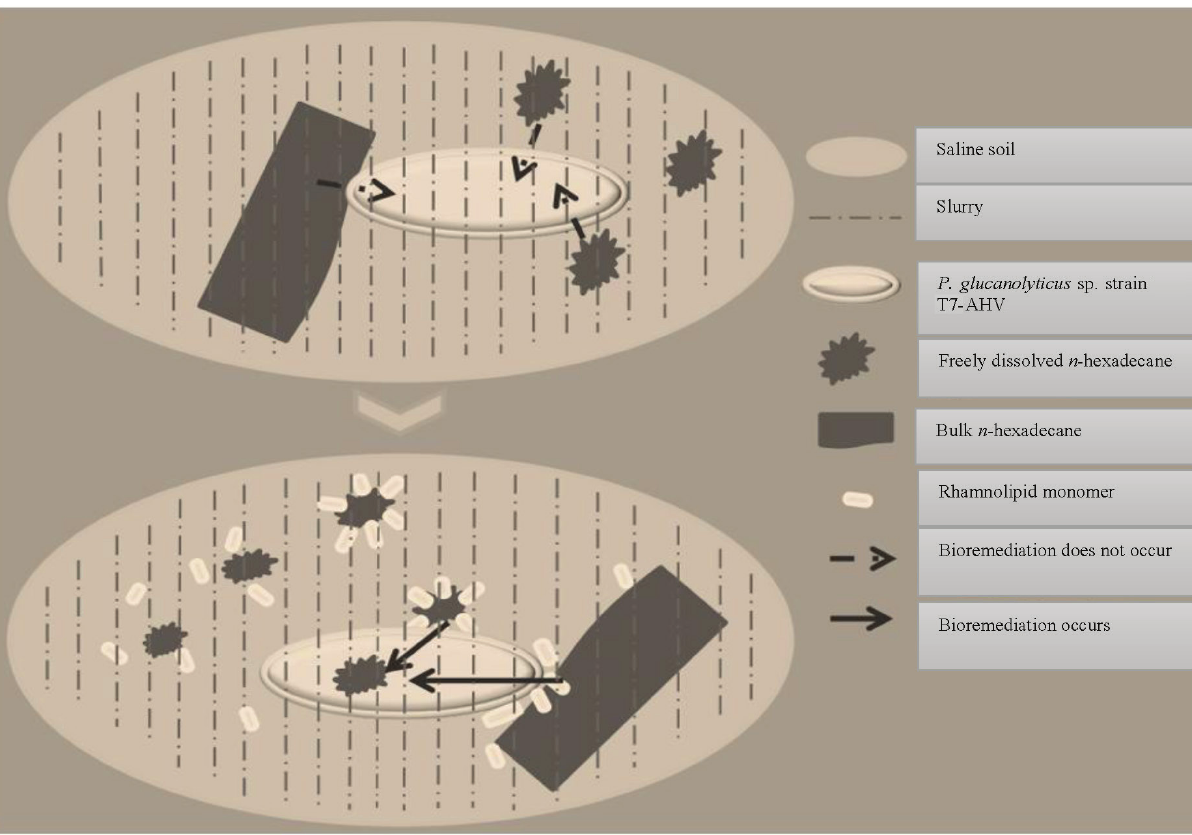
Fig. 5 – Mechanisms of rhamnolipid for enhancing the bioavailability of n-hexadecane by Paenibacillus glucanolyticus sp. strain T7-AHV